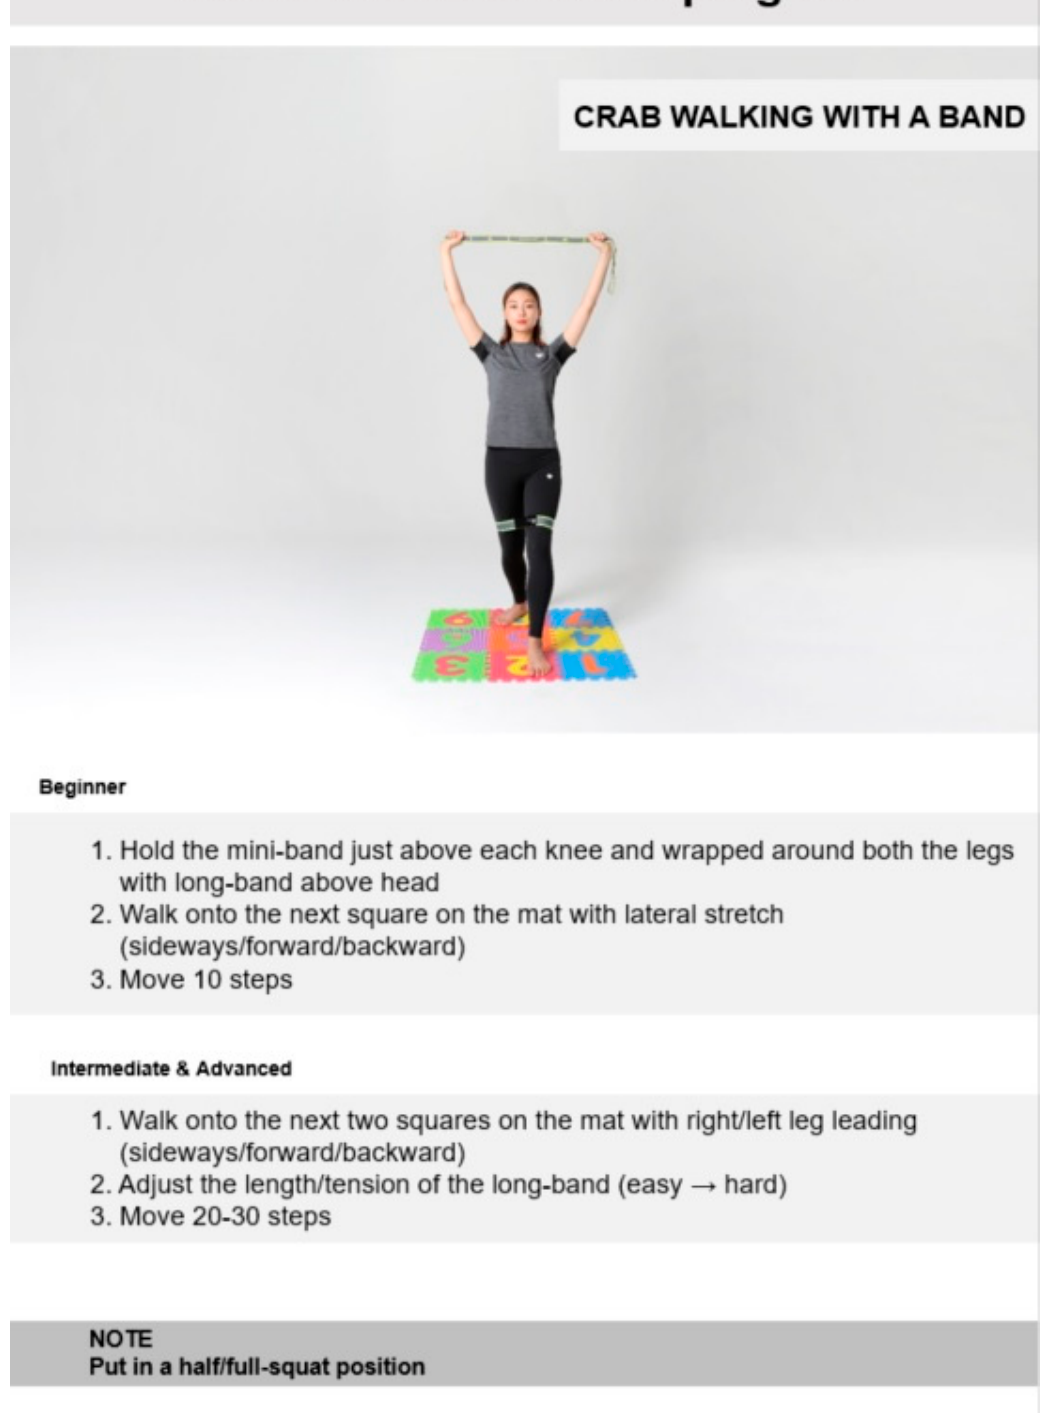
Figure A17. Detailed description and components of each movement in the “Crab walking with band” resistance exercise.